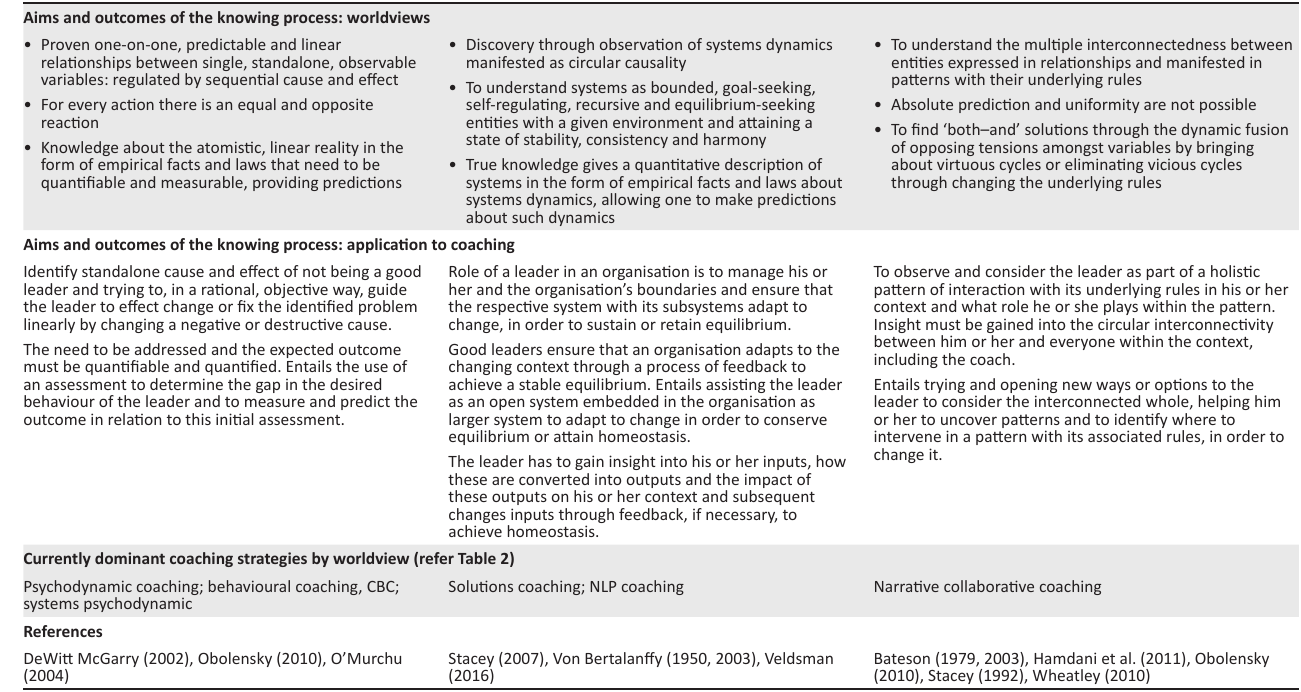
TABLE 3: Aims and outcomes of the knowing process – genuine knowledge about the reality to be known: worldviews and their application to coaching. Newtonian worldview